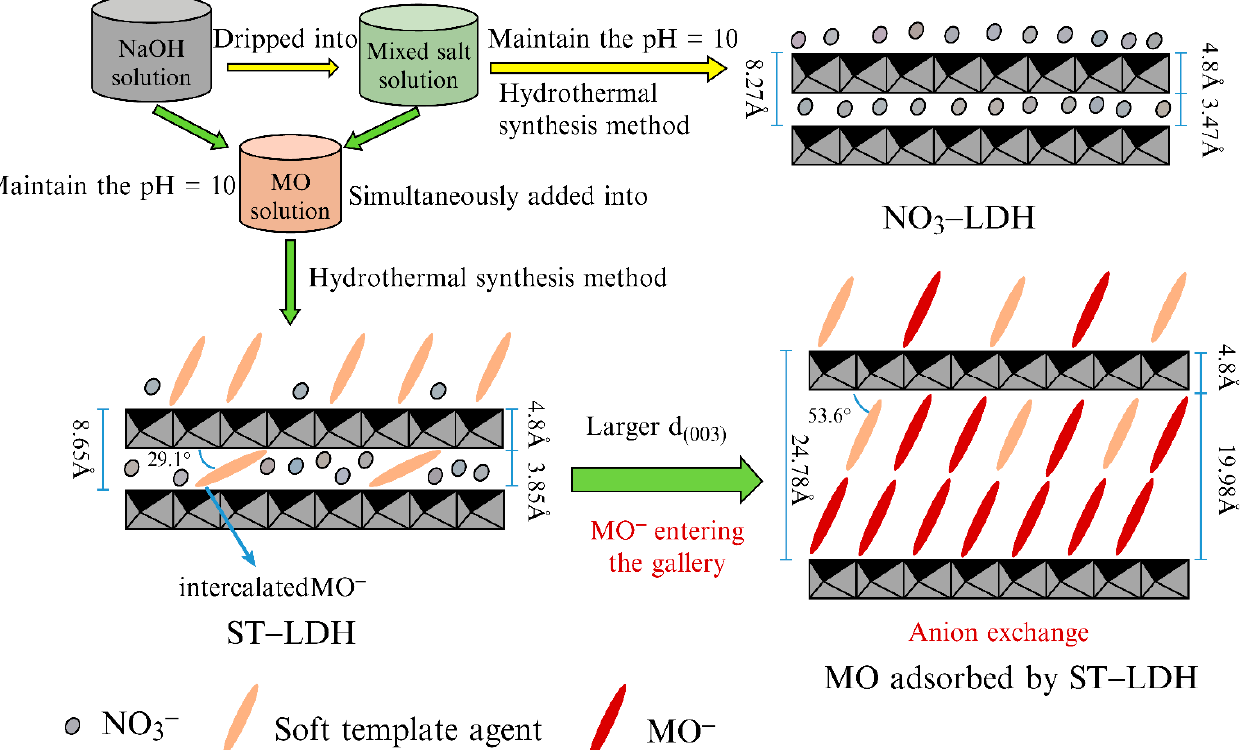
Figure 13. Schematic for the synthetic procedure and adsorption mechanisms of organic Zn–Cr LDH, named ST − LDH, for MO, using a one-step hydrothermal method and MO as a soft template. Reproduced with permission from [118].